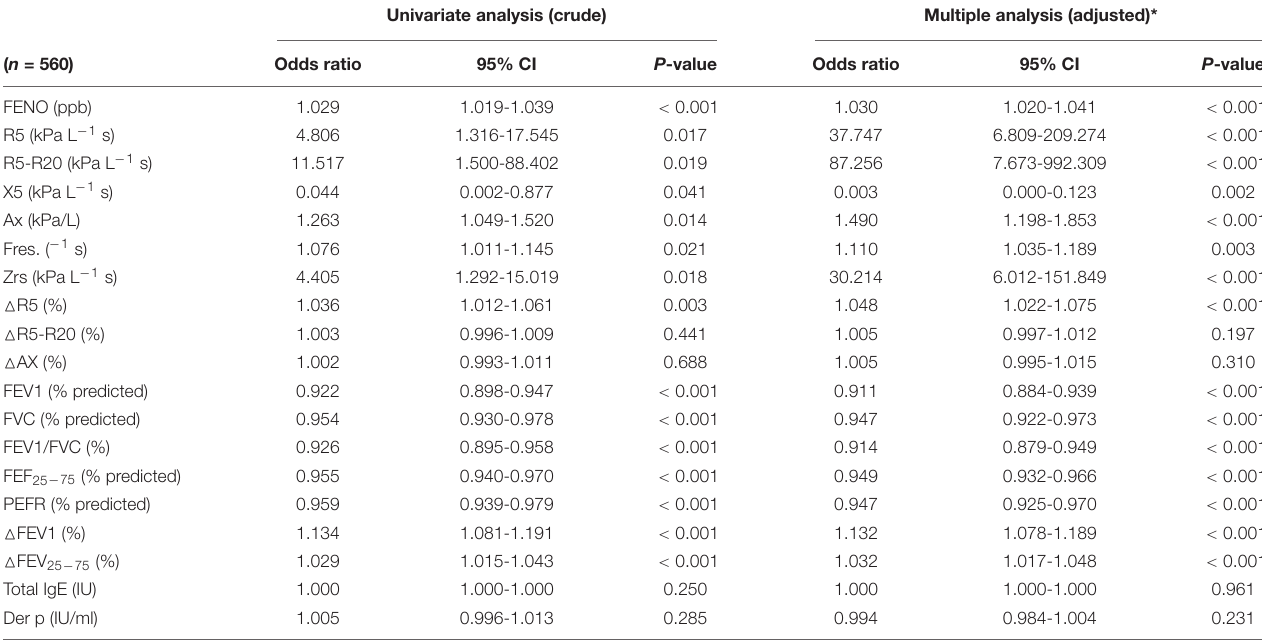
TABLE 6 | Logistic regression analysis of uncontrolled asthma among asthmatic children. Univariate analysis (crude) Multiple analysis